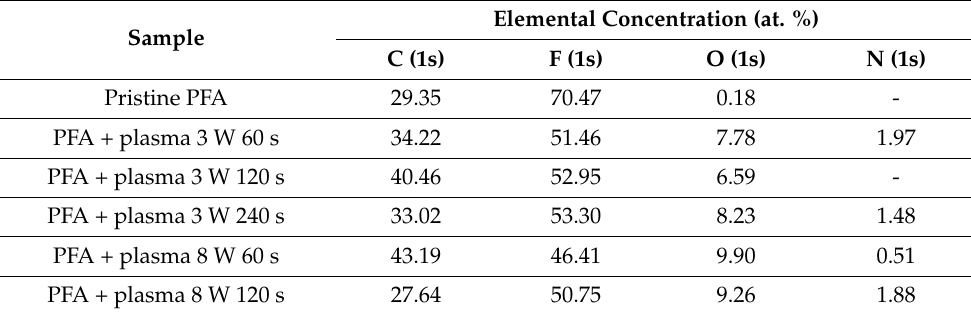
Table 3. Surface atomic concentrations of C, F, O, and N elements determined by XPS analysis in pristine PFA and PFA treated by plasma at 3 and 8 W for 60, 120, and 240 s. The error of measurement did not exceed